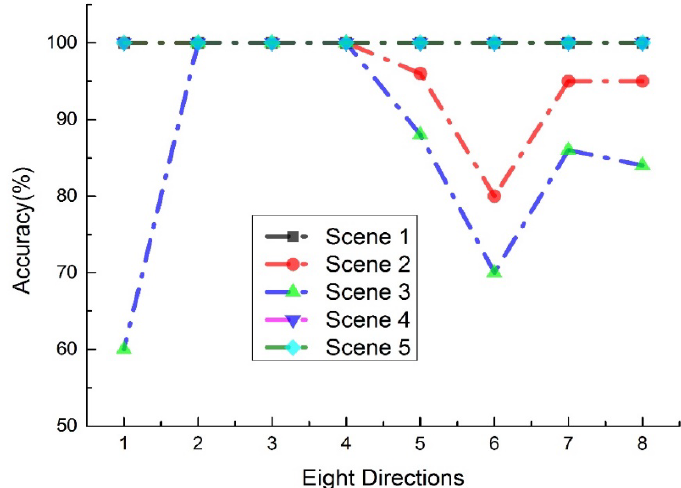
Figure 12. The recognition accuracy of the eight directions in the different backgrounds.